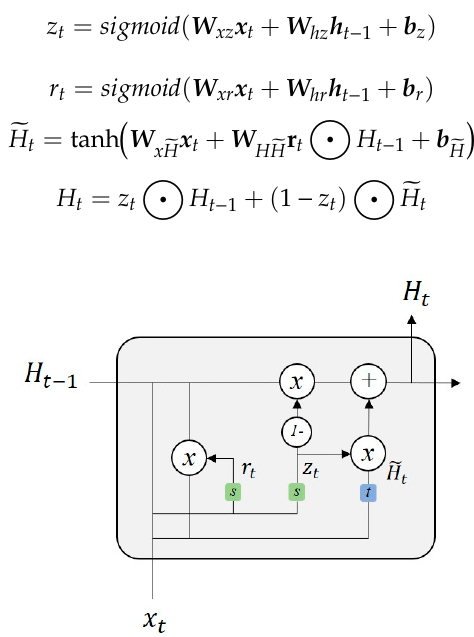
Figure 2. Structure of gated recurrent neural network.